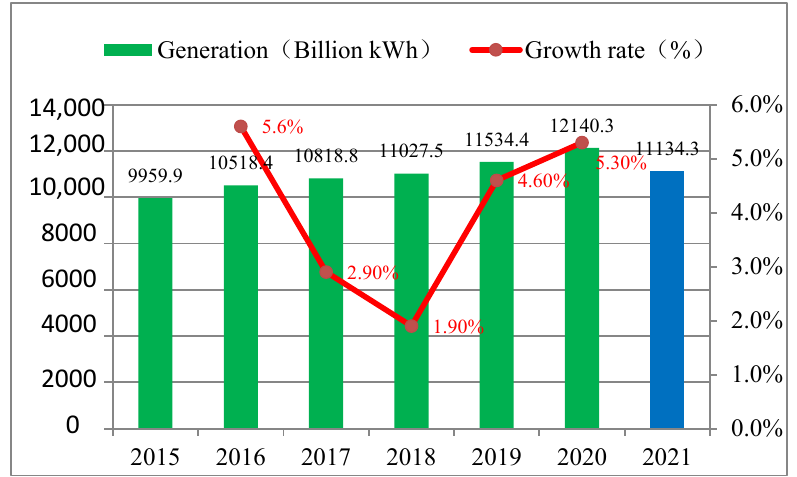
Figure 4. China’s hydropower generation and growth rate from 2015 to 2021.